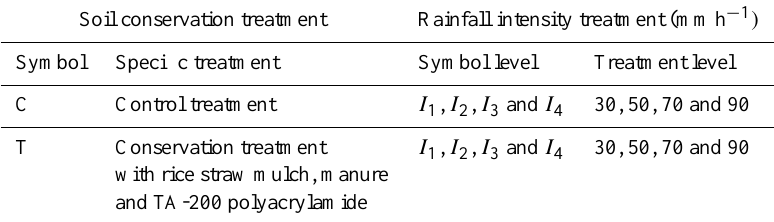
Table 1. Details on experimental setup and study